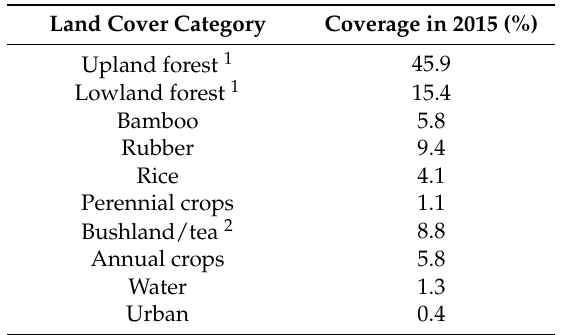
Table 1. Proportions of land cover categories in the Nabanhe Reserve (271 km 2 ) as of 2015.